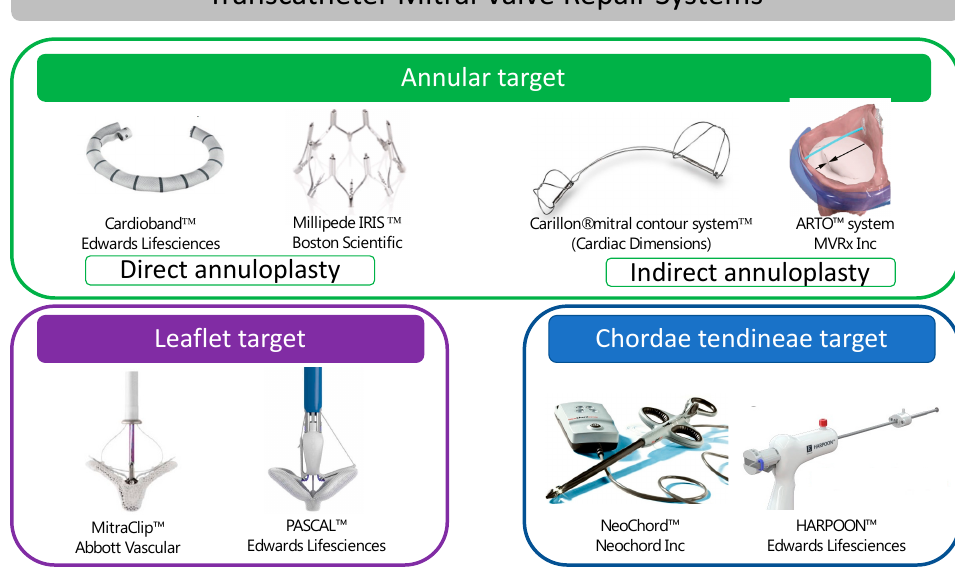
Figure 3. Transcatheter mitral valve repair systems.